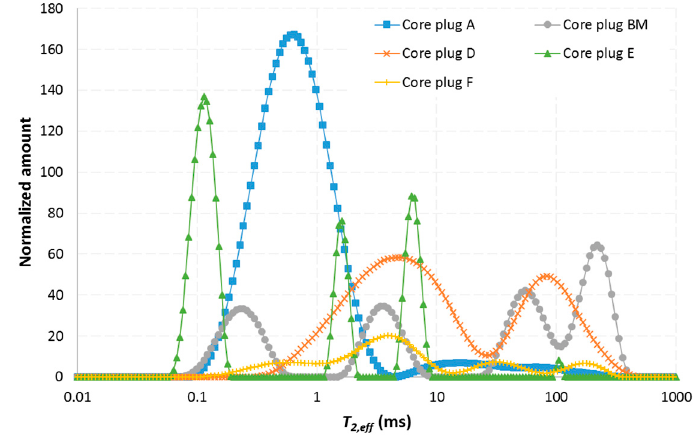
Figure 5. Transverse relaxation distribution for each core plug obtained by the CPMG sequence at low-field strength, B 0 = 0.28 T. Each distribution is normalized with respect to the bulk volume of the respective core plug.